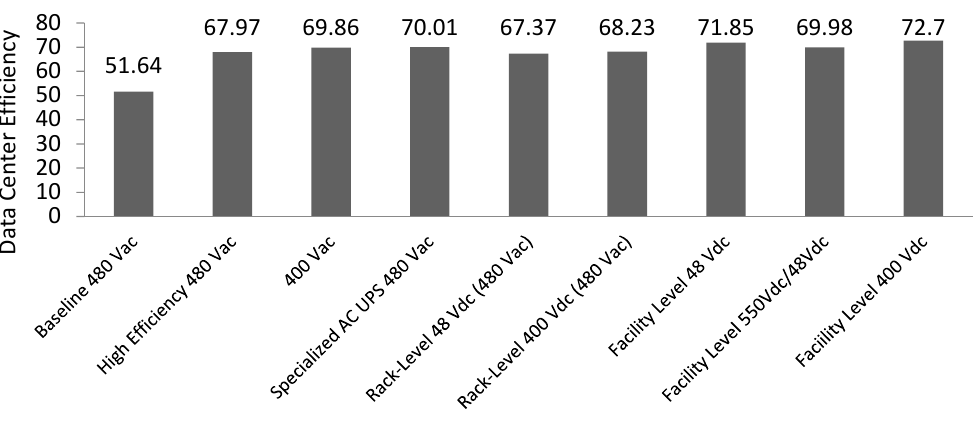
Figure 3. Total Data Center Efficiency as a Function of Supply Voltage